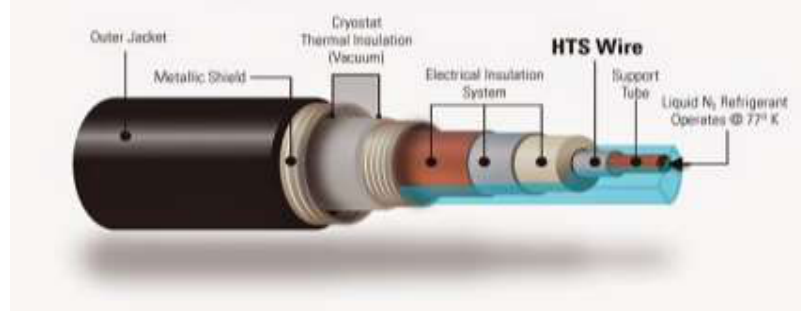
Figure 6: Typical HTS Cable Structure.